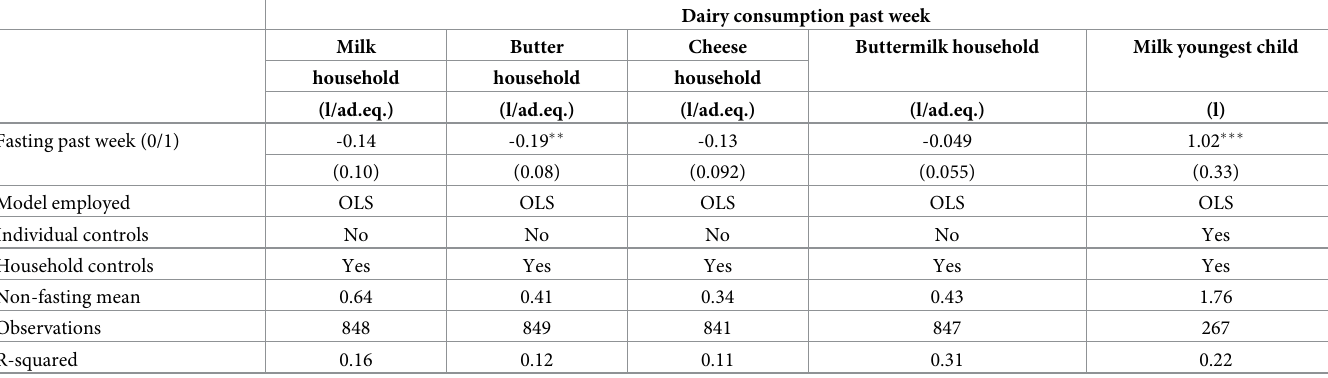
Table 11. Effect of the presence of a fasting period of more than four days in the last week on dairy consumption one week prior to the